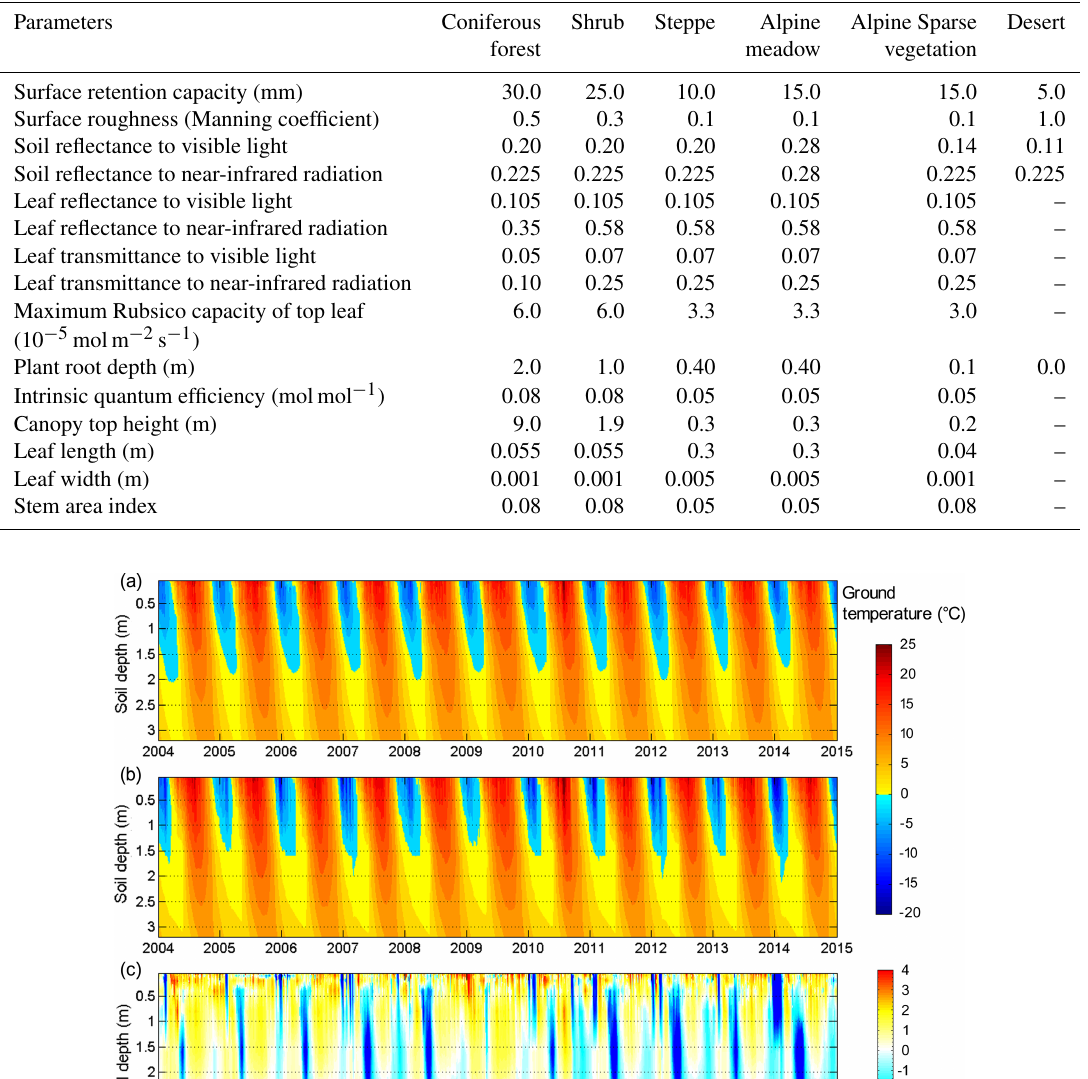
Table 1. Major parameters of the GBEHM model.